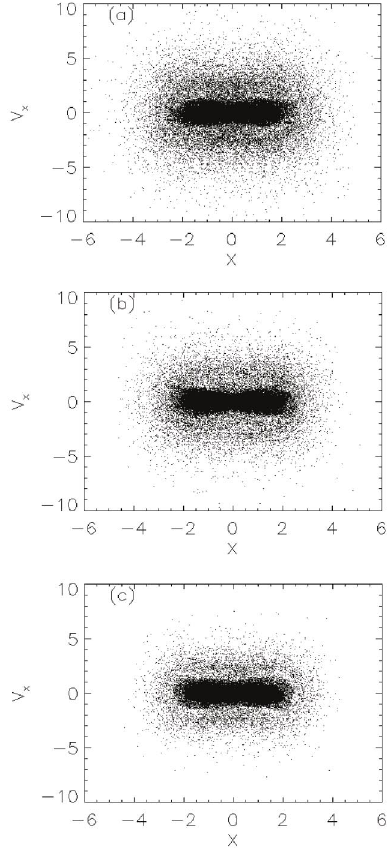
FIG. 10. Phase space distribution of particles just after colli- mation for a beam with nonlinear focusing for (cid:4) (cid:1) (cid:4) a (cid:5) 1.5, (b) 1.35, (c)